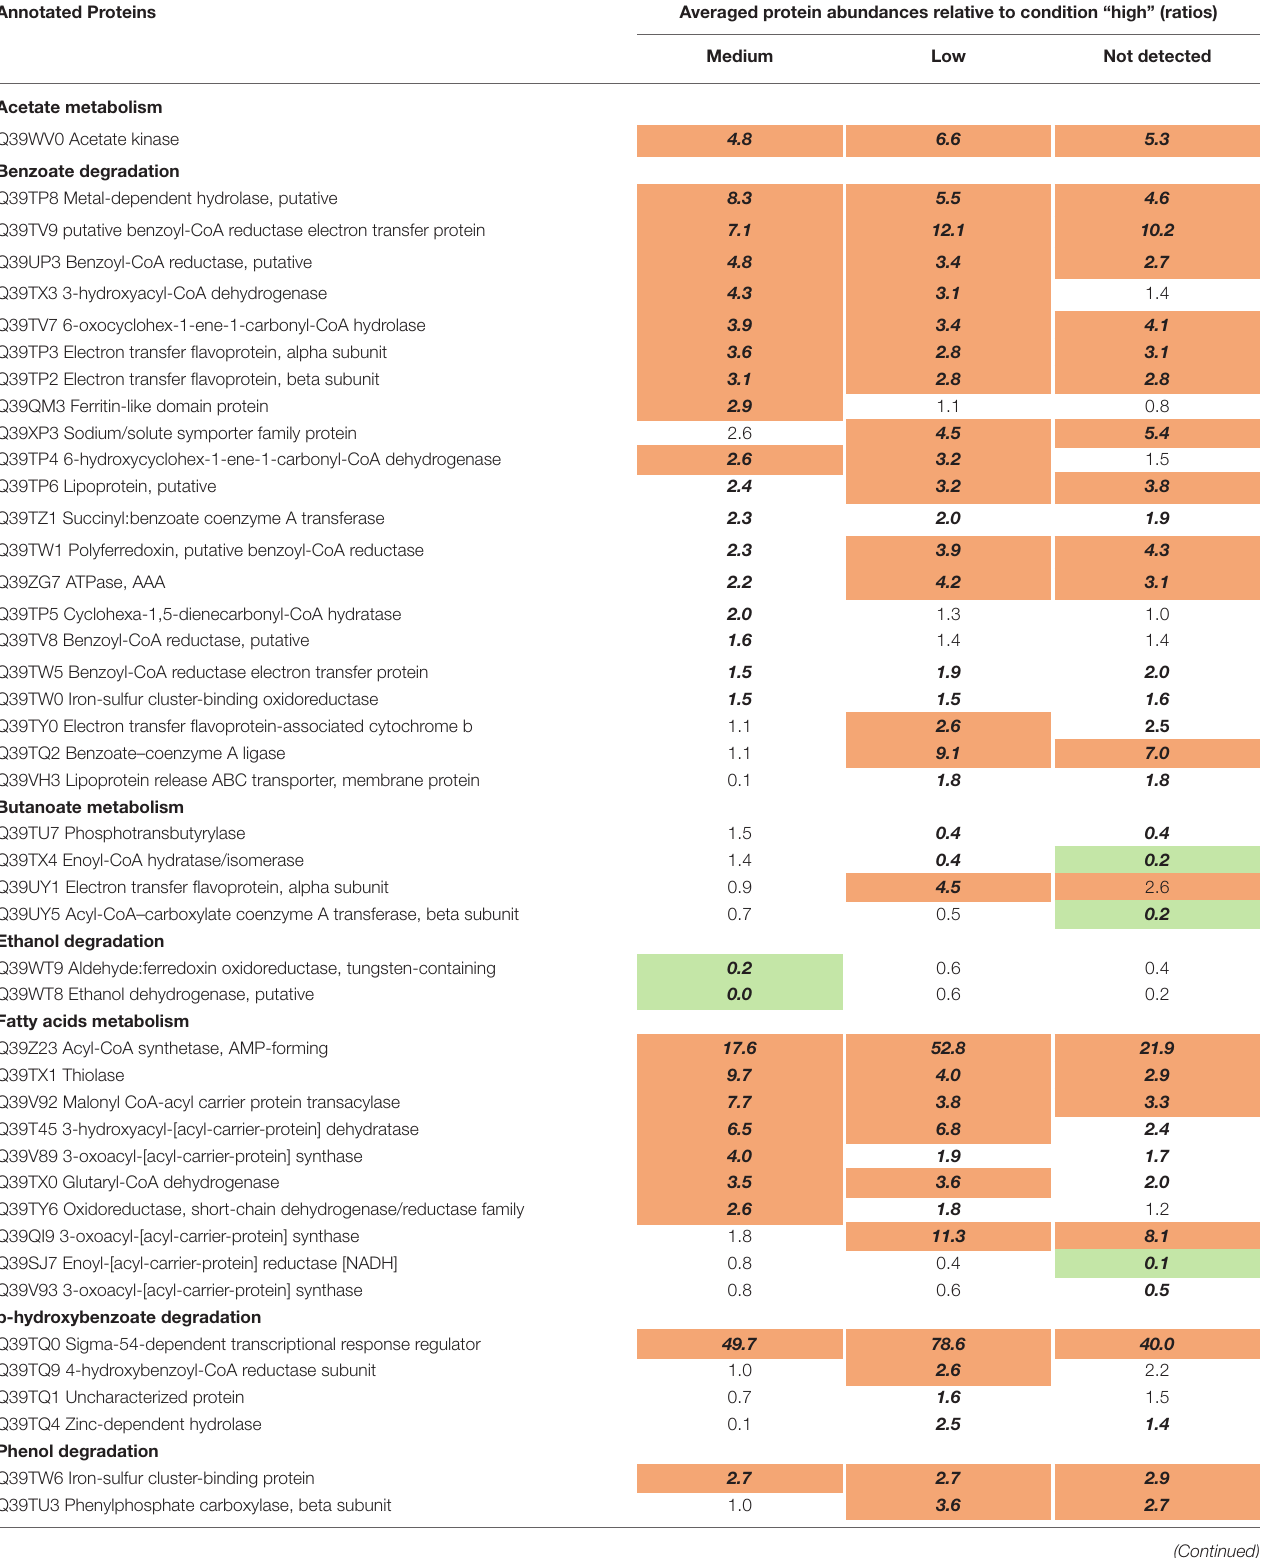
TABLE 1 | List of differentially expressed catabolic proteins identified in Bioconductor (please refer to Material and methods) where the following pair-wise comparisons were performed between the column fractions with different benzoate concentrations: “medium” vs “high,” “low” vs “high,” and “below detection” vs “high.” Annotated Proteins Averaged protein abundances relative to condition “high” (ratios) Medium Low Not detected Acetate